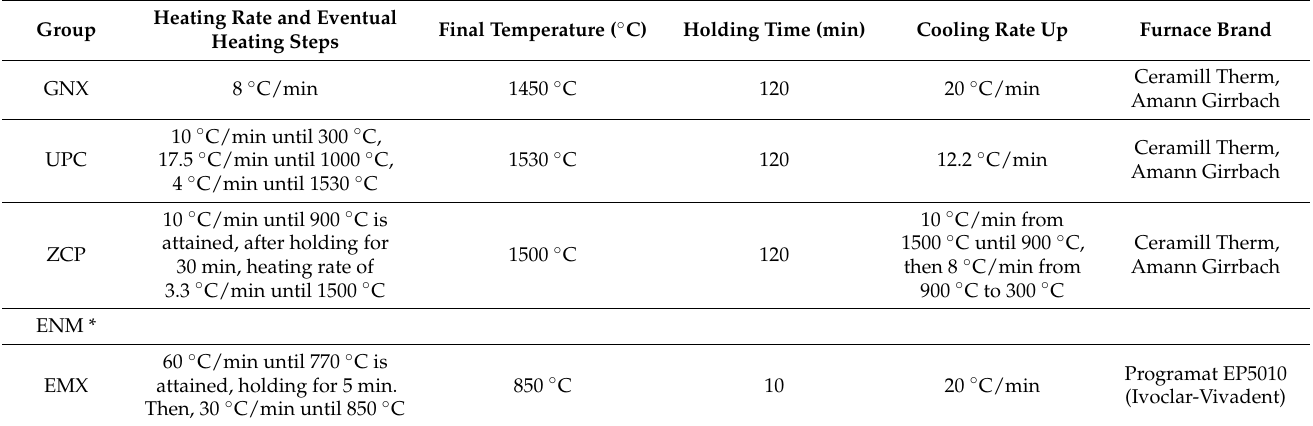
Table 2. Sintering/crystallization parameters used for tested materials. * ENM: It is composed of fully-sintered material, which does not require a ceramic furnace after